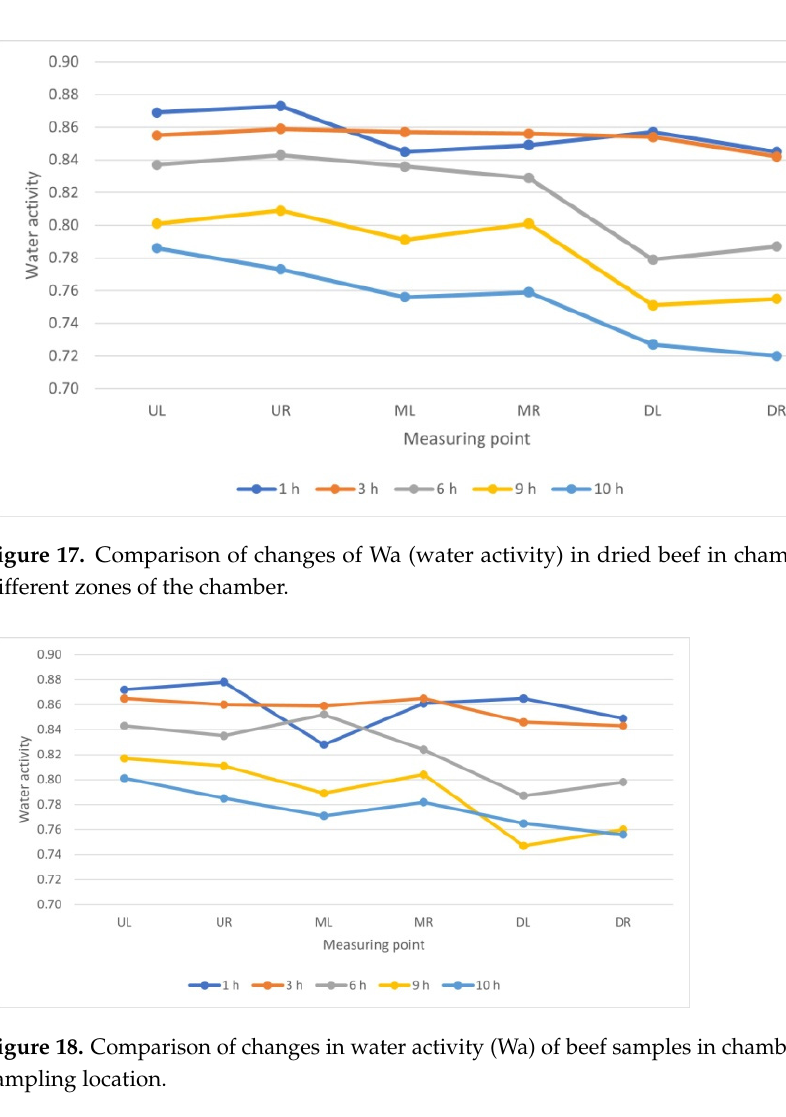
sampling location.